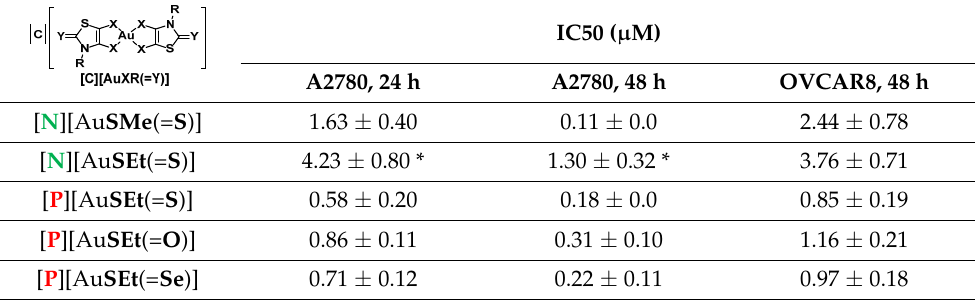
Table 2. IC 50 values ( µ M) calculated for the sixteen Au(III) bis(dithiolene/diselenolene) complexes and the reference drug Cisplatin and Auranofin on the ovarian cancer cells (A2780 and OVCAR8) after 24 and/or 48 h incubation. after 24 and/or 48 h